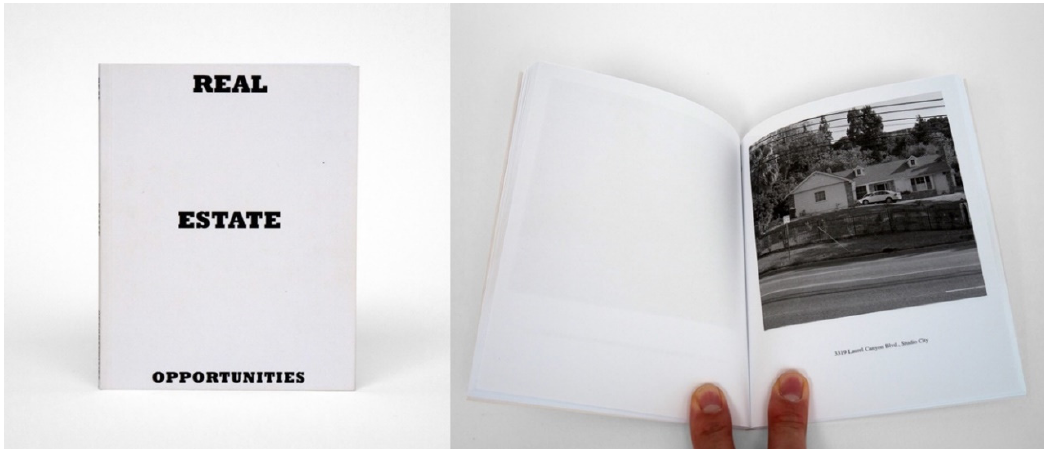
Figure 24. Eric Doeringer, Real Estate Opportunities , 2009.